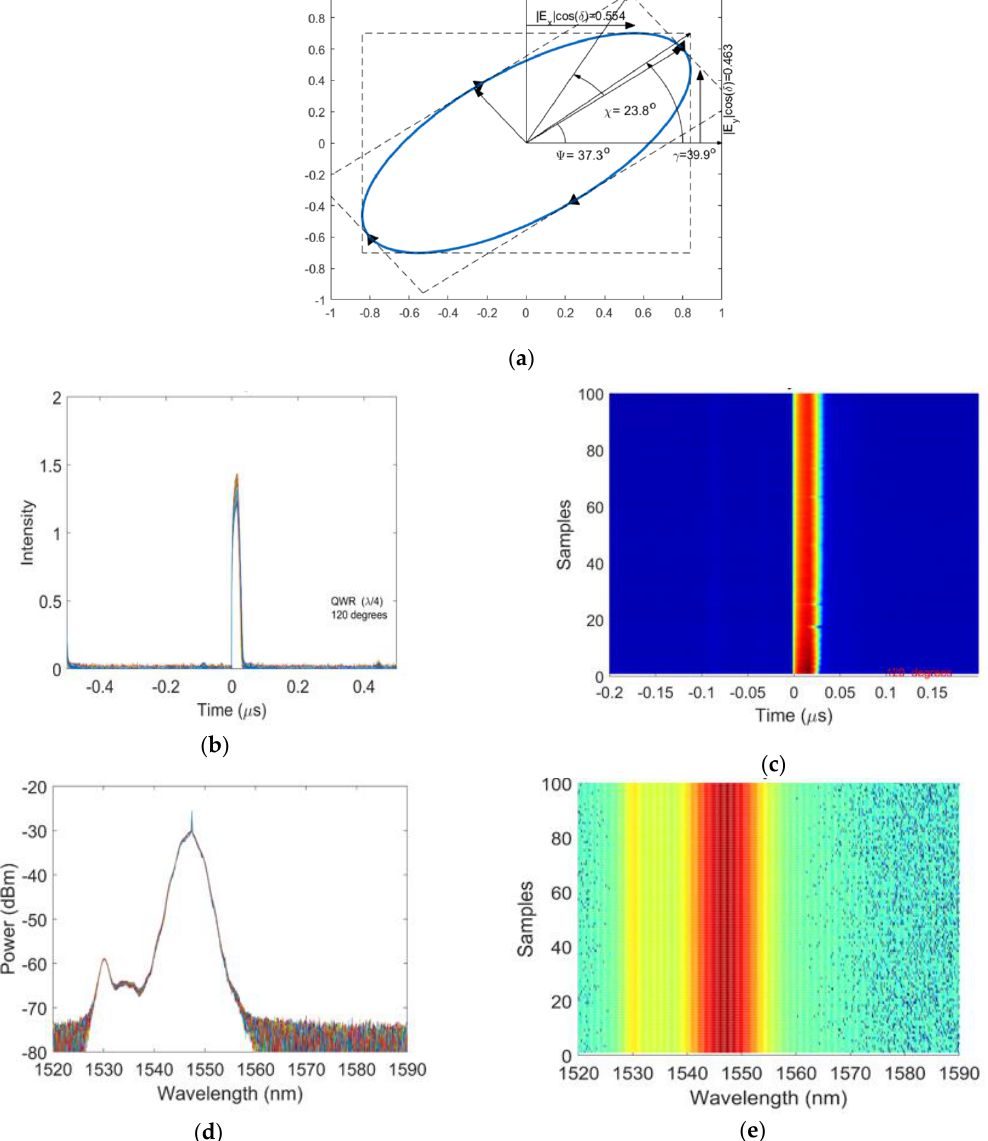
Figure 5. Acquired data simultaneously in real-time for the neural network: ( a ) polarization (right elliptical polarization at 120 ◦ ), ( b ) temporal pulse profiles, ( c ) temporal evolution (100 samples), ( d ) spectra, and ( e ) spectral evolution (100 samples).